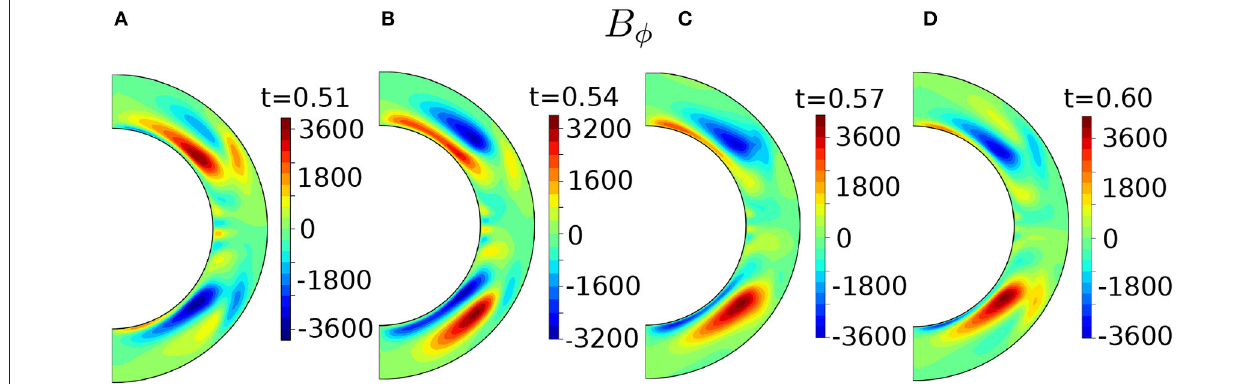
FIGURE 3 | Snapshots of the longitudinally averaged toroidal magnetic field ( B φ ) at different stages during half a solar magnetic cycle. Subfigures show the polarity reversals of the toroidal field. Here, the magnetic field is in a non-dimensional unit, a value of 1 corresponds to 20 Gauss.